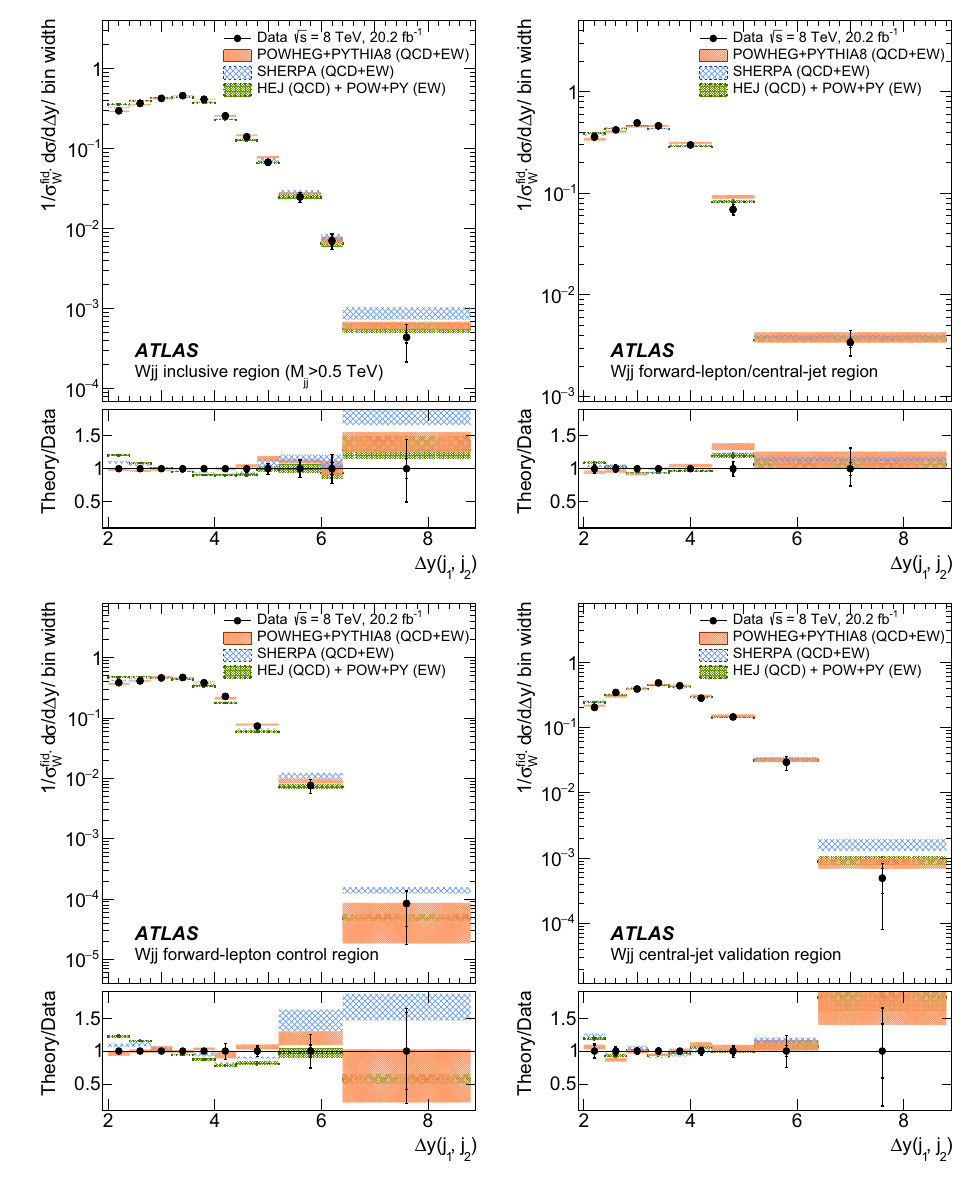
Fig. 18 Unfolded normalized differential W jj production cross sec- tionsasafunctionof (cid:6) y ( j 1 , j 2 ) intheinclusive,forward-lepton/central- jet, forward-lepton, and central-jet fiducial regions. Both statistical